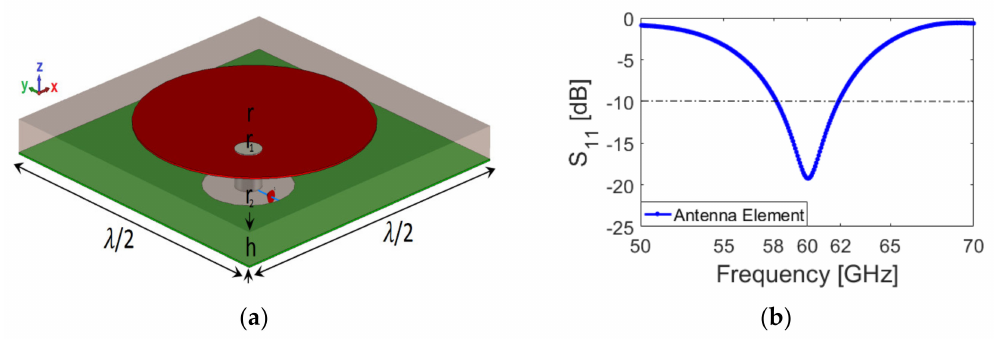
Figure 2. The proposed antenna’s 3D model and reflection coefficient: ( a ) 60 GHz compact − size circular patch antenna; ( b ) reflection